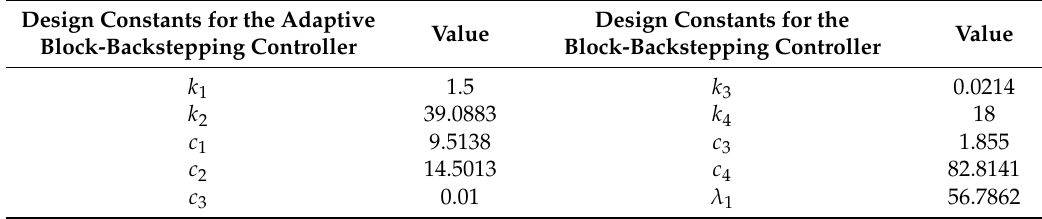
Table 2. Optimal design constants of both schemes of the block-backstepping controllers. Design Constants for the Adaptive Block-Backstepping Controller